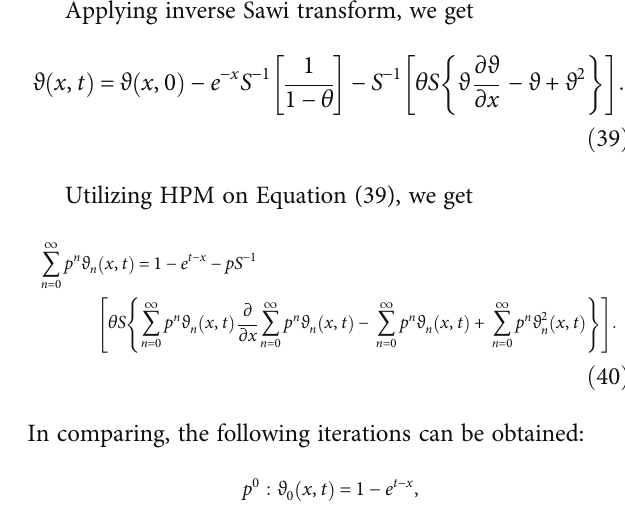
Figure 4: 2D plot for ϑ ð x , t Þ with various parameter of t .